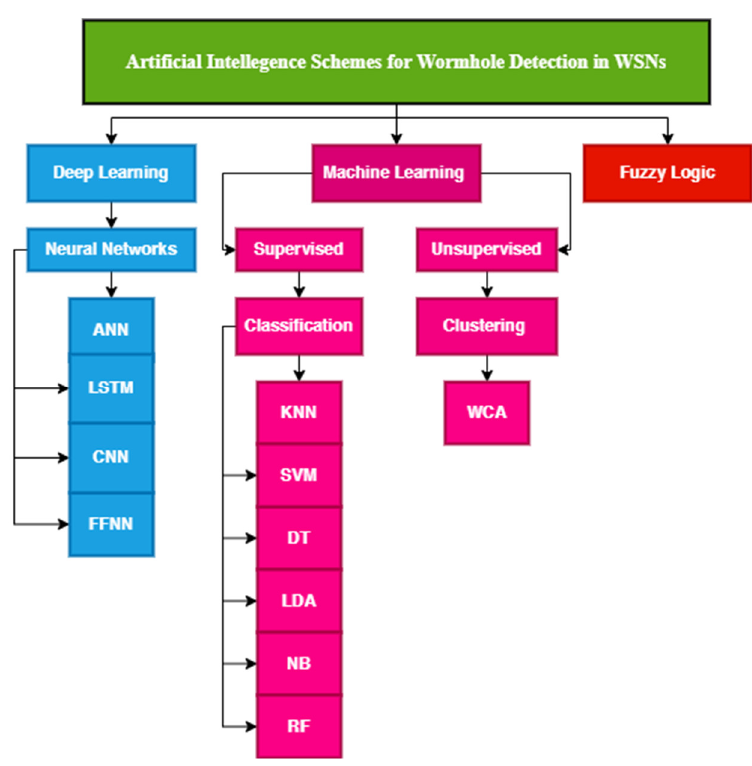
Figure 6. Classification of AI- and ML-based wormhole detection schemes.